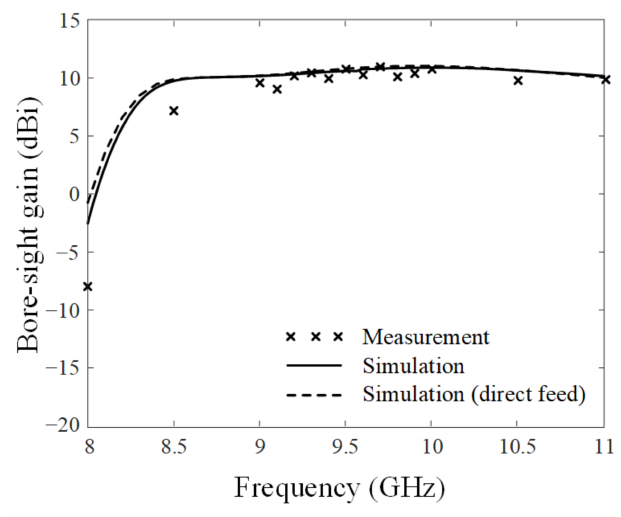
Figure 9. Bore-sight gain of the 2 × 2 array.